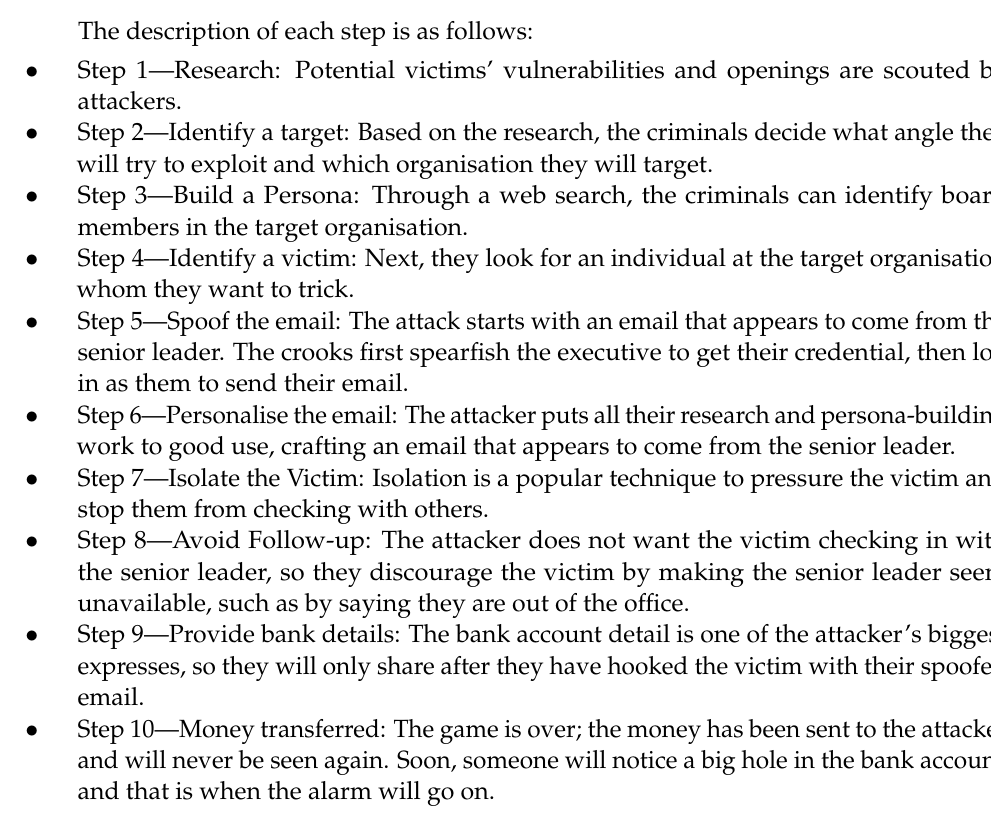
Figure 1. Common steps of performing a BEC